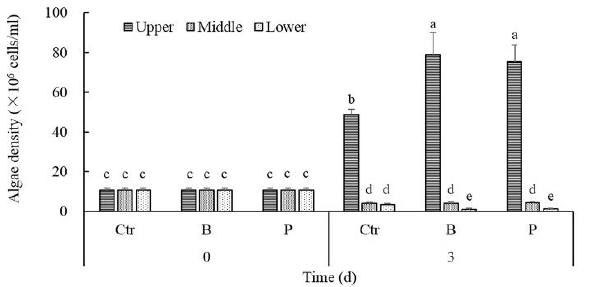
Figure 1. The effect of algicidal and denitrifying bacteria on the vertical distribution of M. aeruginosa .